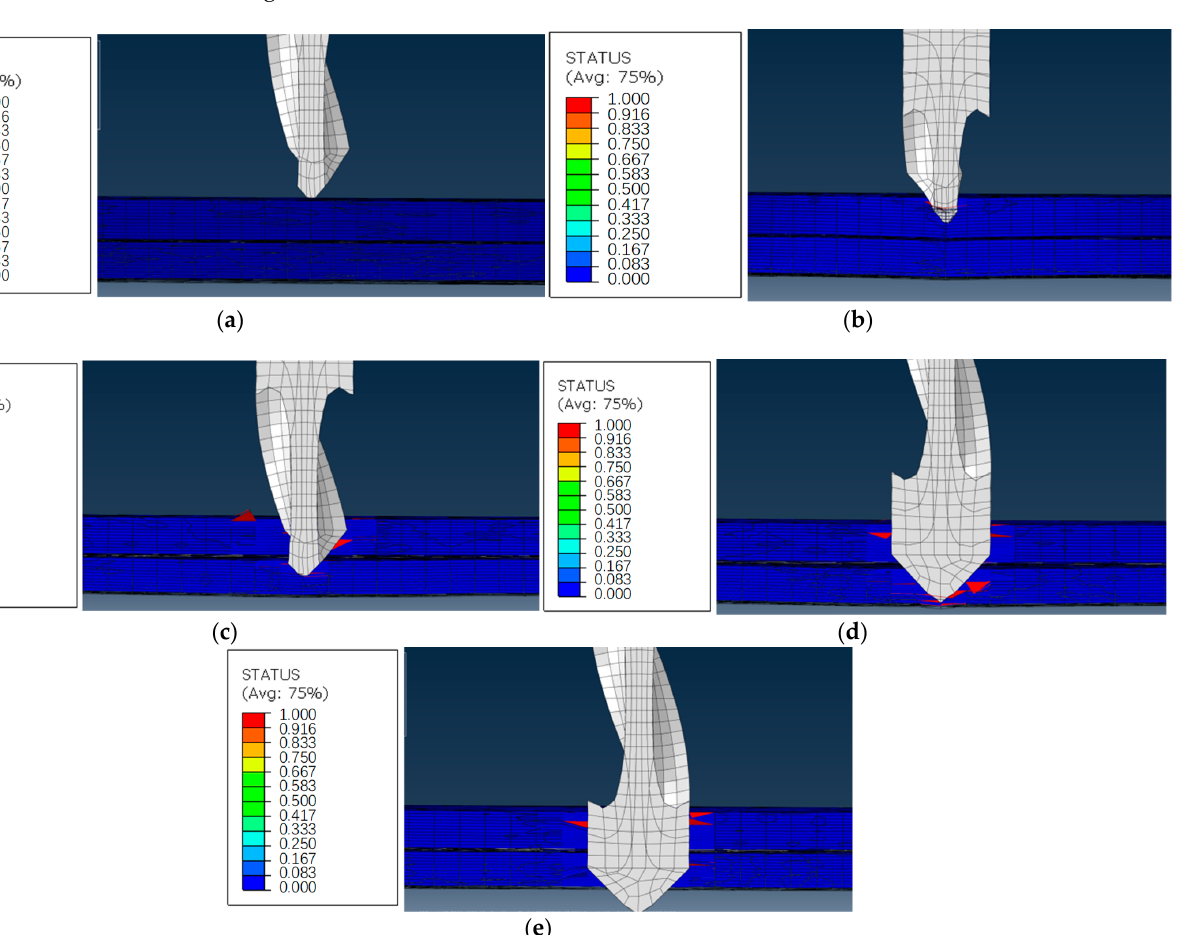
Figure 7. Axial force time curve of composites at constant and dynamic rotations speed: ( a ) Constant speed 2000 r/min, ( b ) Dynamic speed 2000 – 4000 r/min.